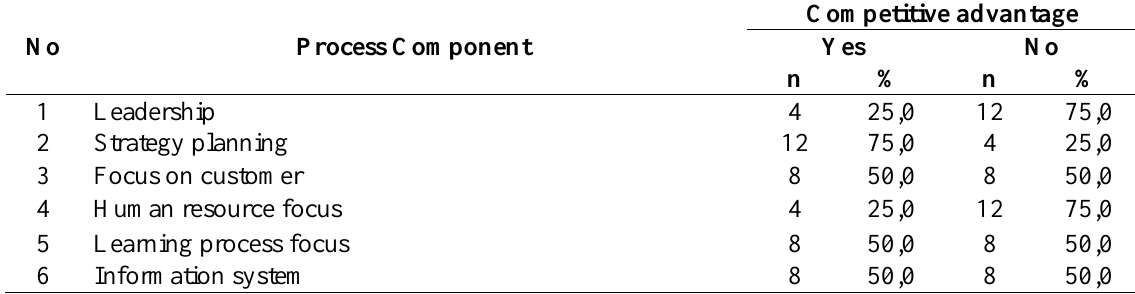
Table 2. The components of the quality process in nursing schools under Muhammadiyah